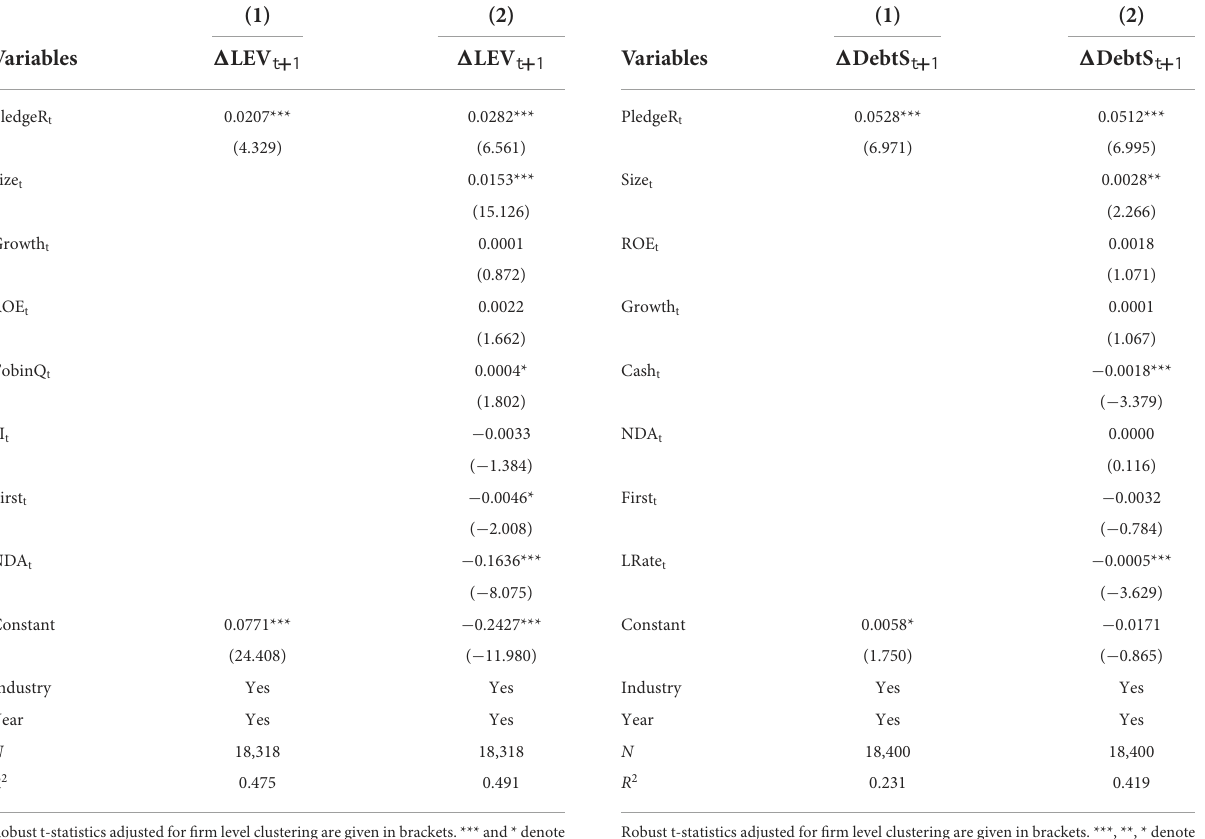
TABLE 8 Robustness: the regression results of changing financial leverage variables.